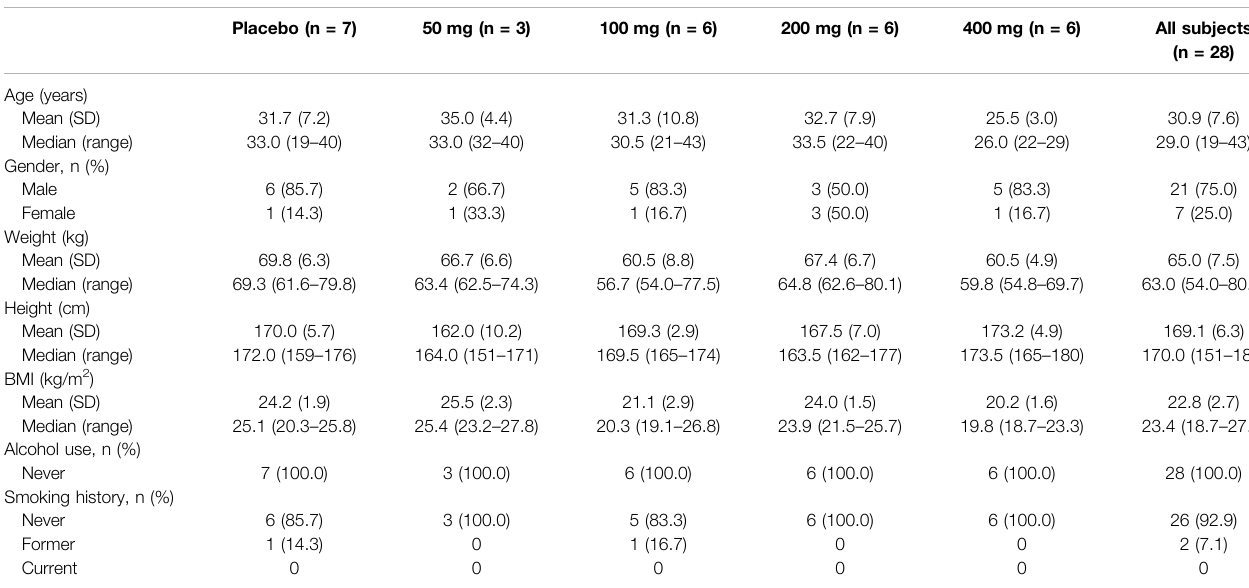
TABLE 1 | Baseline